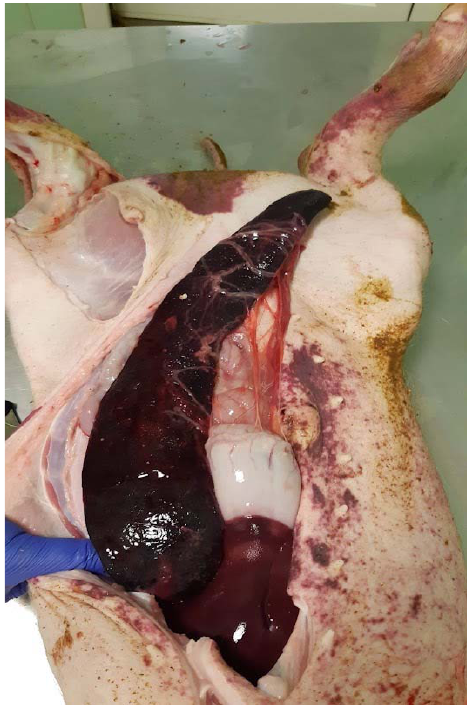
Figure 8. Severe clinical outcomes of S. suis infection. Animal No. 2 in the control group developed serious clinical outcomes of S. suis infection. Here, petechial body hemorrhage and splenomegaly are shown.